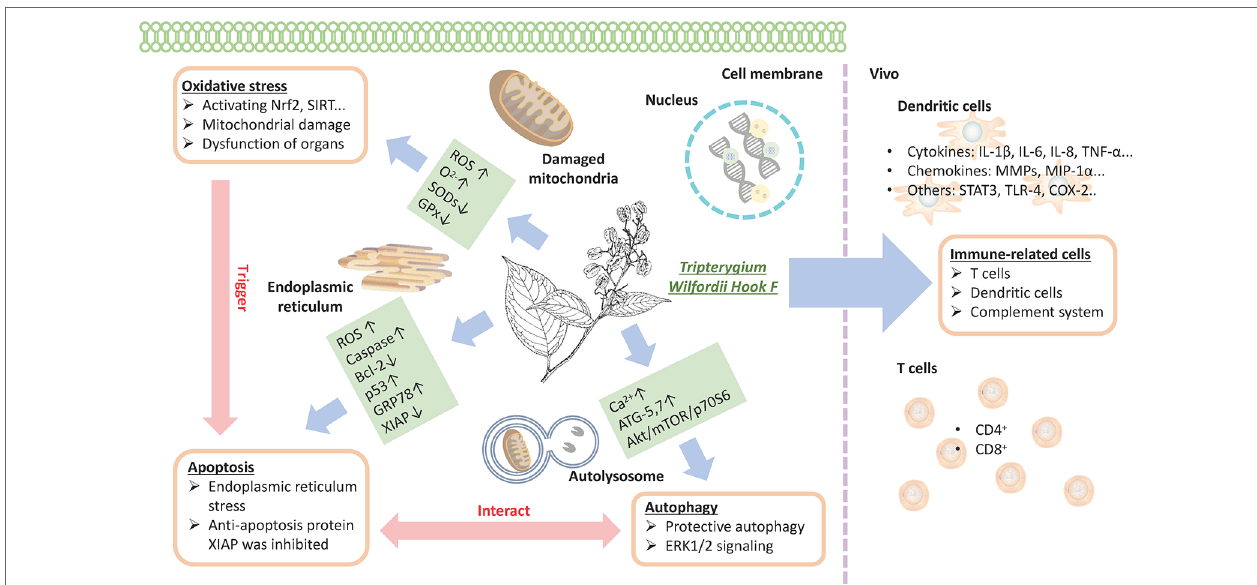
FIGURE 6 | TwHF inhibits the activity of immune cells and prevents T-cell proliferation with the reduction in proinflammatory cytokines and chemokines; TwHF alters intracellular GSH levels, resulting in the overproduction of ROS, leading to mitochondrial damage; TwHF increases the generation of anion superoxide (O 2- ), inhibits the activity of antioxidant enzymes such as SOD and catalase, and induces oxidative stress and dysfunction in organs. Meanwhile, oxidative stress is an important factor in the induction of apoptosis. TwHF treatment activated caspase-3, caspase-8, and caspase-9, and p53 and downregulated Bcl-2 levels in mitochondria- initiated apoptosis. TwHF can increase the expression of GRP78 to inhibit endoplasmic reticulum stress and induce protective autophagy; it also inhibits apoptosis by eliminating dysfunctional mitochondria. TwHF, Tripterygium wilfordii Hook F; GSH, glutathione; ROS, reactive oxygen species; SOD, superoxide